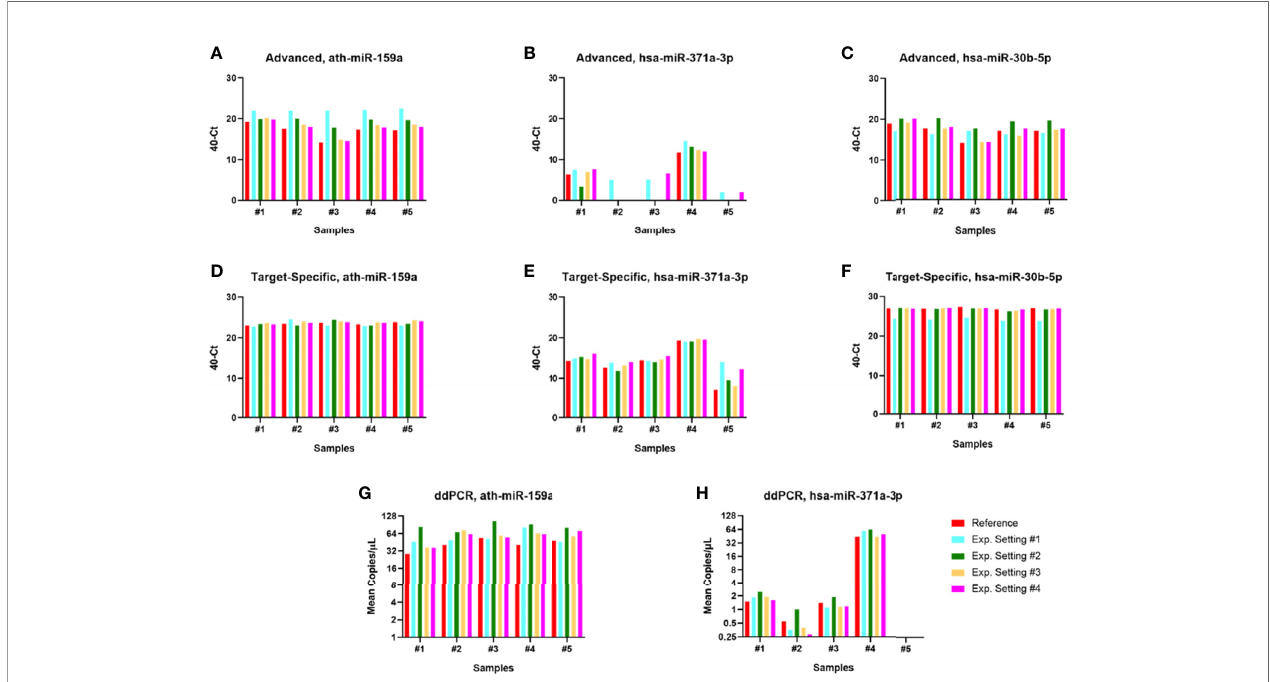
FIGURE 5 | Comparison of pipelines. (A – C) TaqMan Advanced (global) microRNA pipeline. (D – F) TaqMan (target-speci fi c) microRNA pipeline. (G, H) DigiMir pipeline. The x -axis represents the samples used for the optimization phase: #1 and #2 — stage I seminomas; #3 — stage II embryonal carcinoma; #4 — stage III embryonal carcinoma; #5 — age-matched healthy blood donor. The color code refers to experimental settings: setting #1 — different extraction; setting #2 — different cDNA synthesis; setting #3 — different operator; setting #4 — same operator; and reference for